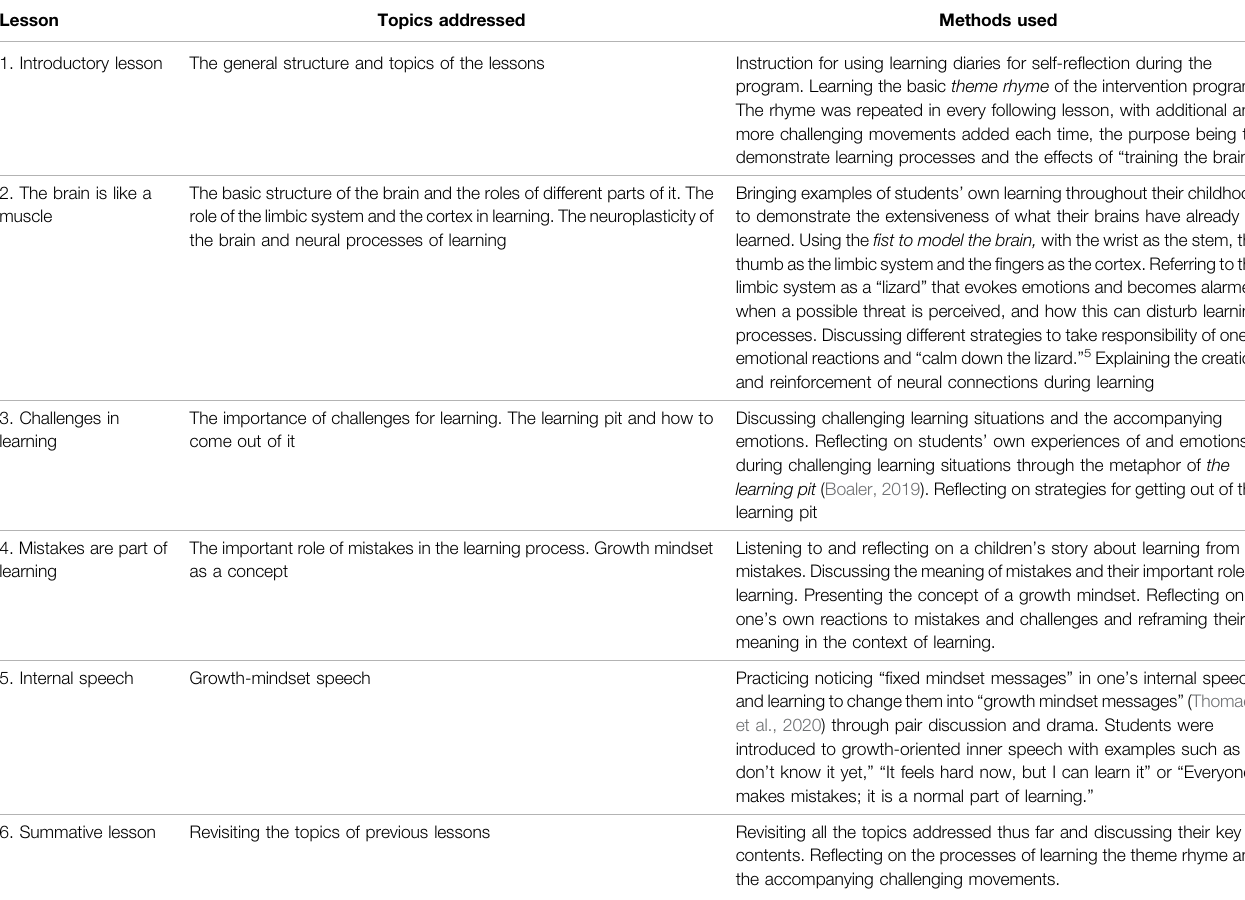
TABLE 1 | An overview of the lessons, topics and methods of the GMP intervention program.